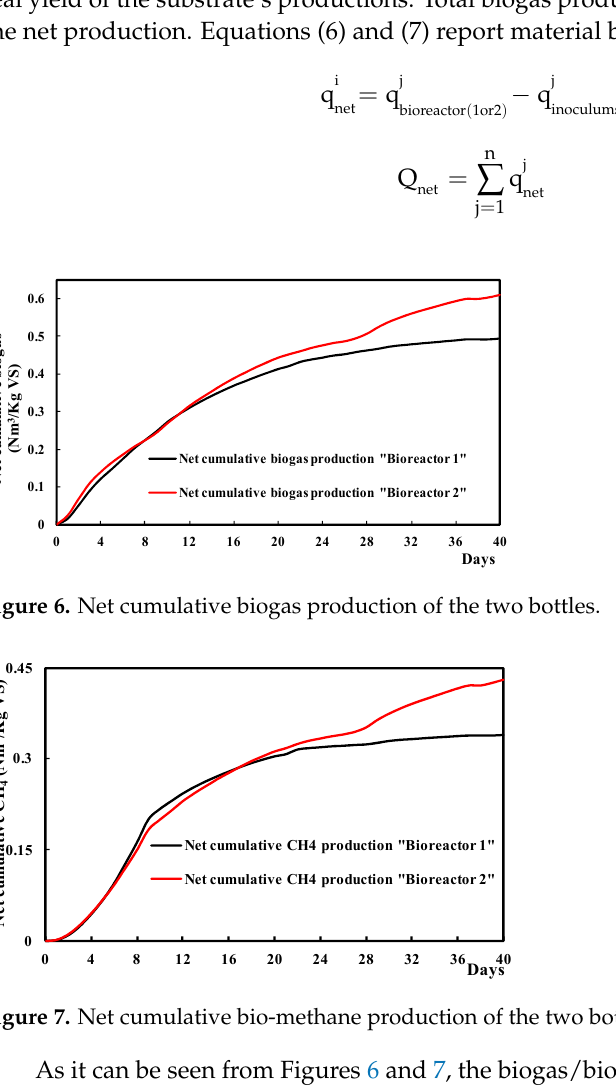
Figure 8. Daily net bio-methane production of the two bottles.